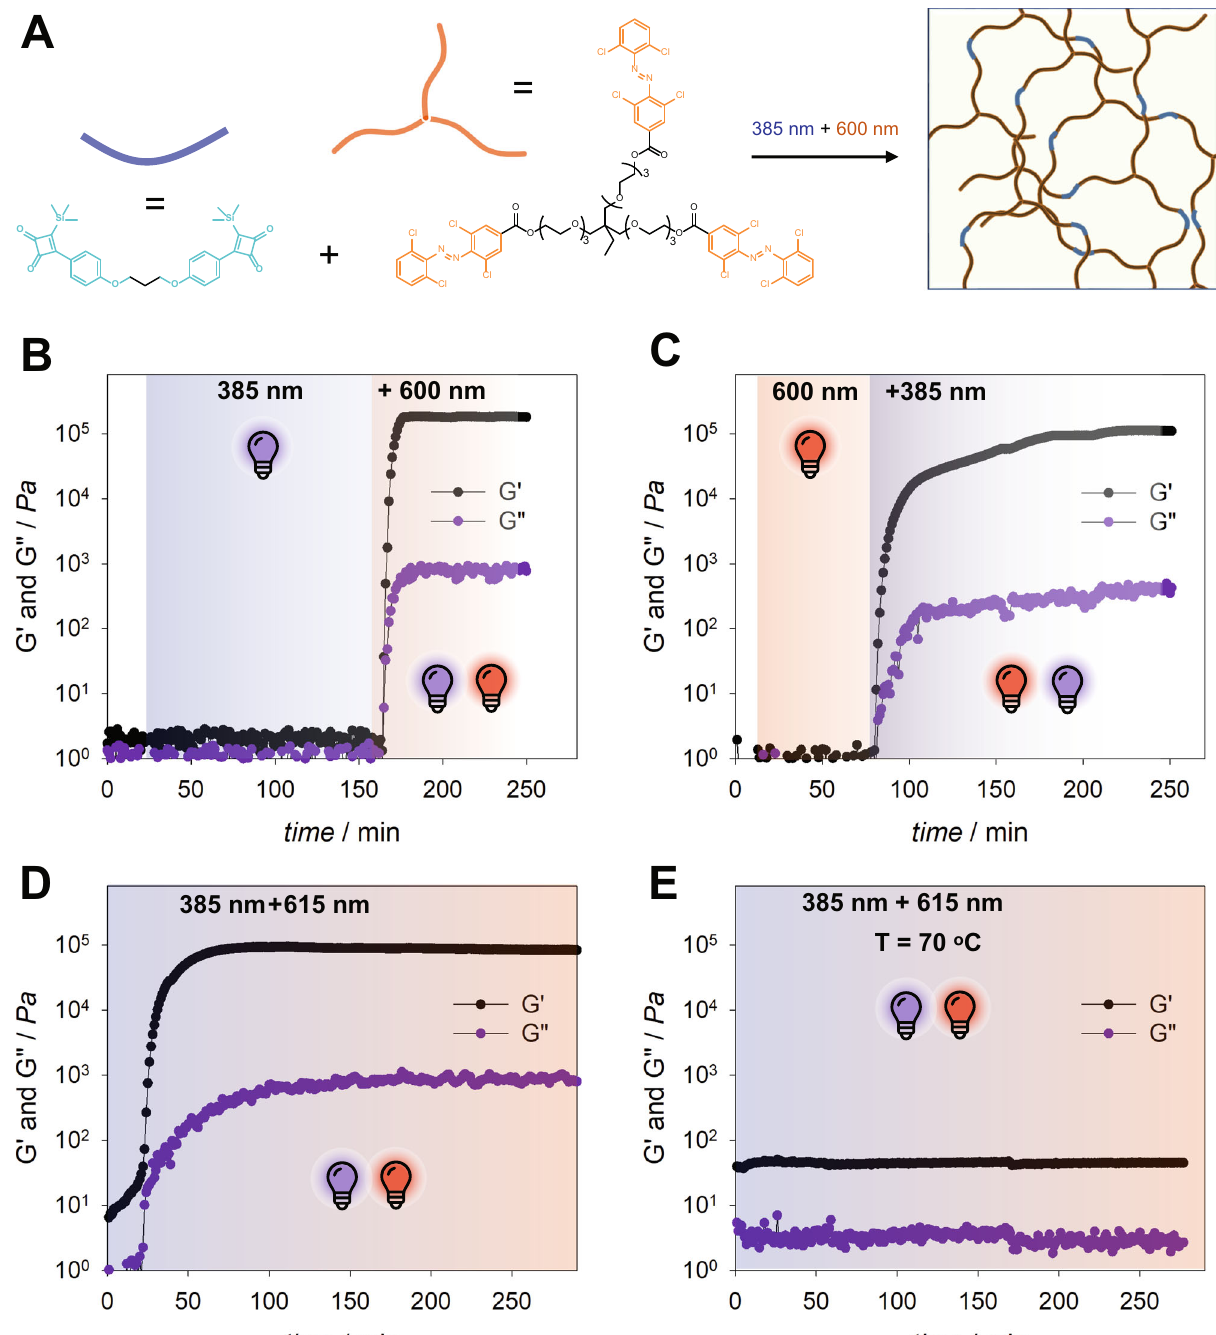
Fig. 5 Dual-colour initiated polymer crosslinking. A Representation of the crosslinking process between a biscyclobutenedione and a three-arm PEG functionalised with ortho -substituted tetrachloride azobenzene under two-colour irradiation. Rheological investigation of the crosslinking process under different irradiation conditions, showing the evolution of G ′ and G ″ values as the function of time: B the resin was irradiated fi rst with UV light (385 nm), followed by red light (600 nm), C the resin was irradiated with red light, followed by UV light, at certain time interval UV light was switched off, halting the increase in G ′ value, D the resin was irradiated by both red and UV lights simultaneously, and E the resin was heated to 70 °C and irradiated with both